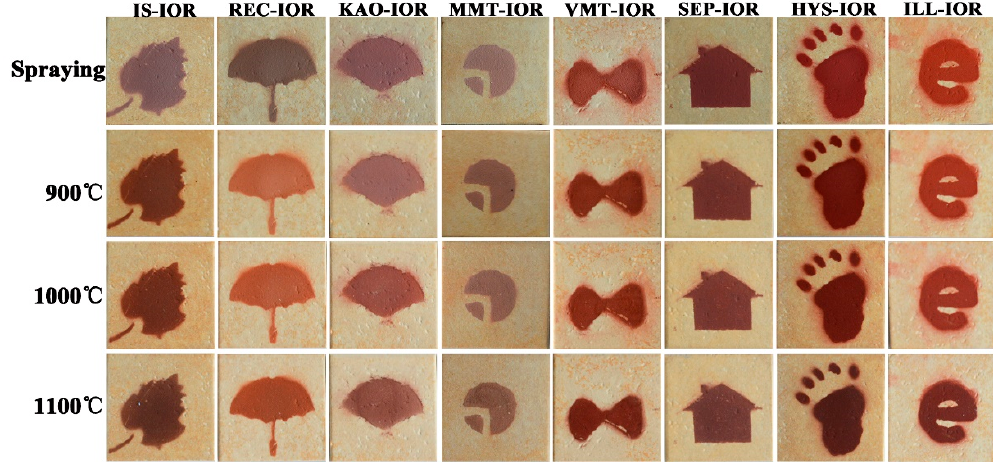
Figure 9. Digital photos of sprayed coatings on ceramic substrate after calcinations at different temperatures (900 °C, 1000 °C, and 1100 °C). temperatures (900 ◦ C, 1000 ◦ C, and 1100 ◦